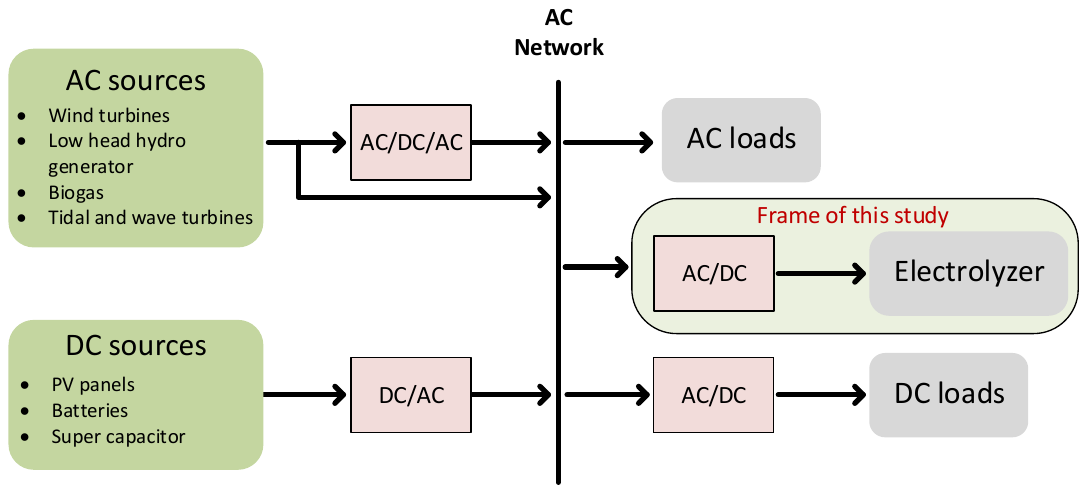
Figure 1. AC microgrid